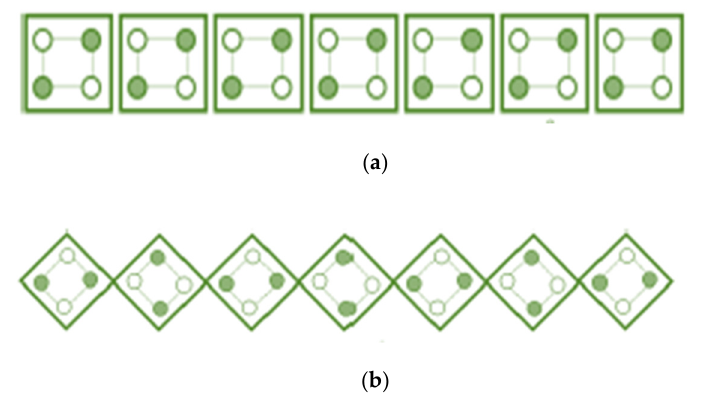
Figure 2. ( a ) 90 ◦ QCA wire. ( b ) 45 ◦ QCA wire [2,25]. Figure 2. ( a ) 90° QCA wire. ( b ) 45° QCA wire [2,25] . Figure 2. ( a ) 90° QCA wire. ( b ) 45° QCA wire [2,25] .